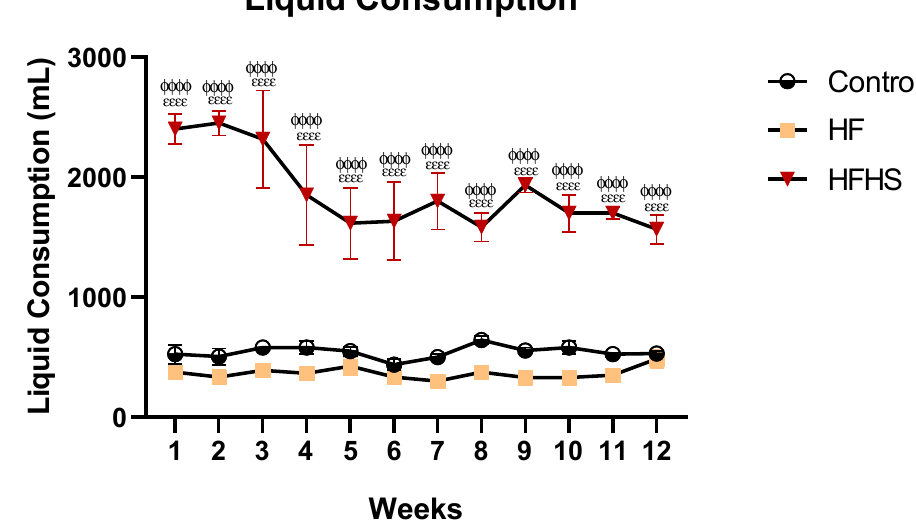
Data are presented as mean ± SEM. ϕϕϕϕ p < 0.0001 HFHS versus controls; εεεε p < 0.0001 HFHS versus HF.